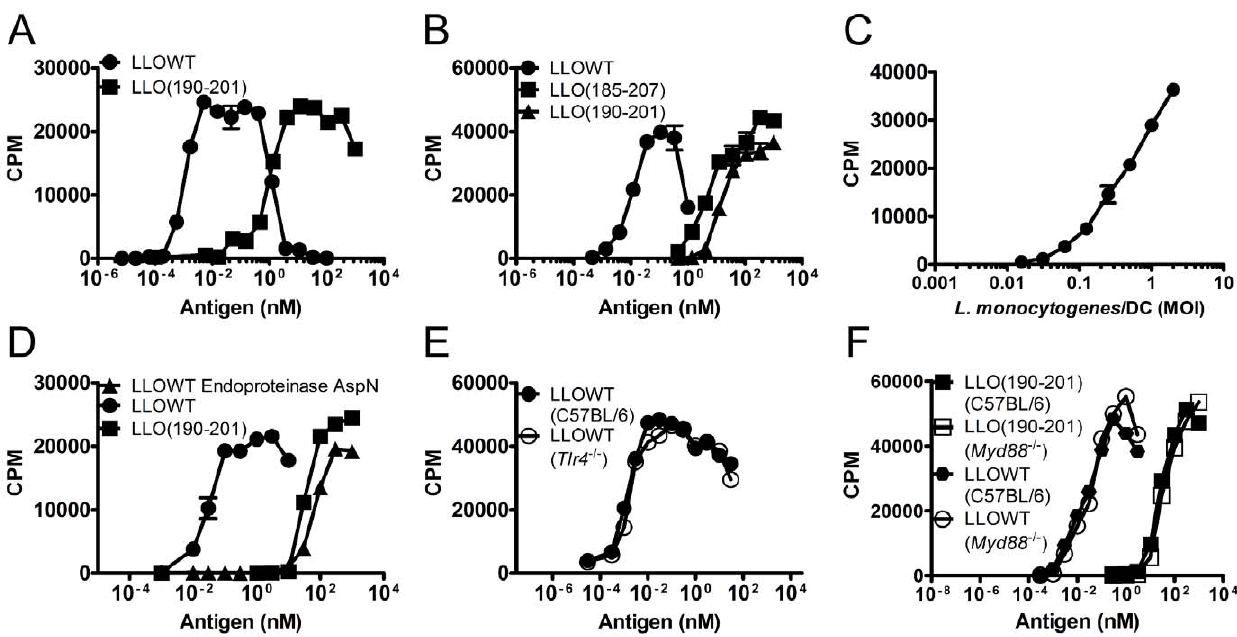
Figure 3. Enhanced presentation of an LLO protein-derived CD4 T cell epitope. A–B. 5 6 10 4 I-A b -restricted LLO(190–201)-specific hybridomas 57-3 ( A ) or LL73 ( B ) were incubated for 16 h with 10 5 PEC ( A ) or 5 6 10 4 BMDC ( B ) from C57BL/6 mice and various concentrations of either LLOWT, LLO(190–201), or LLO(187–205). C. BMDC (10 5 ) were infected with the indicated MOI of L. monocytogenes EGD strain as in [45] and 16 hrs. later the response of 57-3 (5 6 10 4 ) was determined. D. LLO was treated with endoproteinase AspN or buffer for , 16 hr. at 37 u C then incubated with for , 16 hr. with 10 5 irradiated C57BL/6 splenocytes and 57-3 (5 6 10 4 ). E , Tlr4 2 / 2 , ( F ) Myd88 2 / 2 (KO), or ( E–F ) C57BL/6J (WT) irradiated splenocytes (10 5 ) were treated with LLOWT or LLO(190–201) and ( E ) 57-11 or ( F ) 57-3 T cell hybridomas (5 6 10 4 ). Following all incubations, T cell hybridoma activation was determined by CTLL-2 assay. Points indicate the mean 6 S.D.